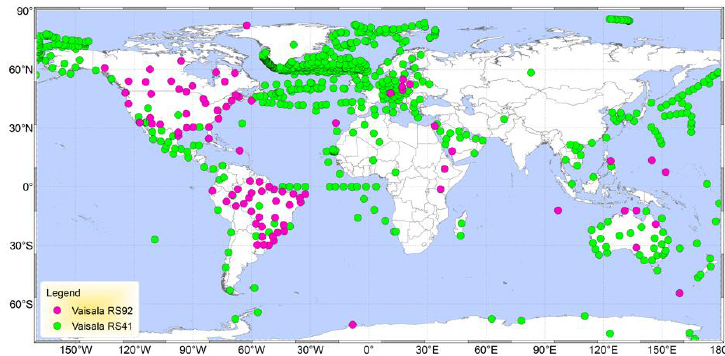
Figure 3. The geophysical locations for RS41 data from June to October 2019.